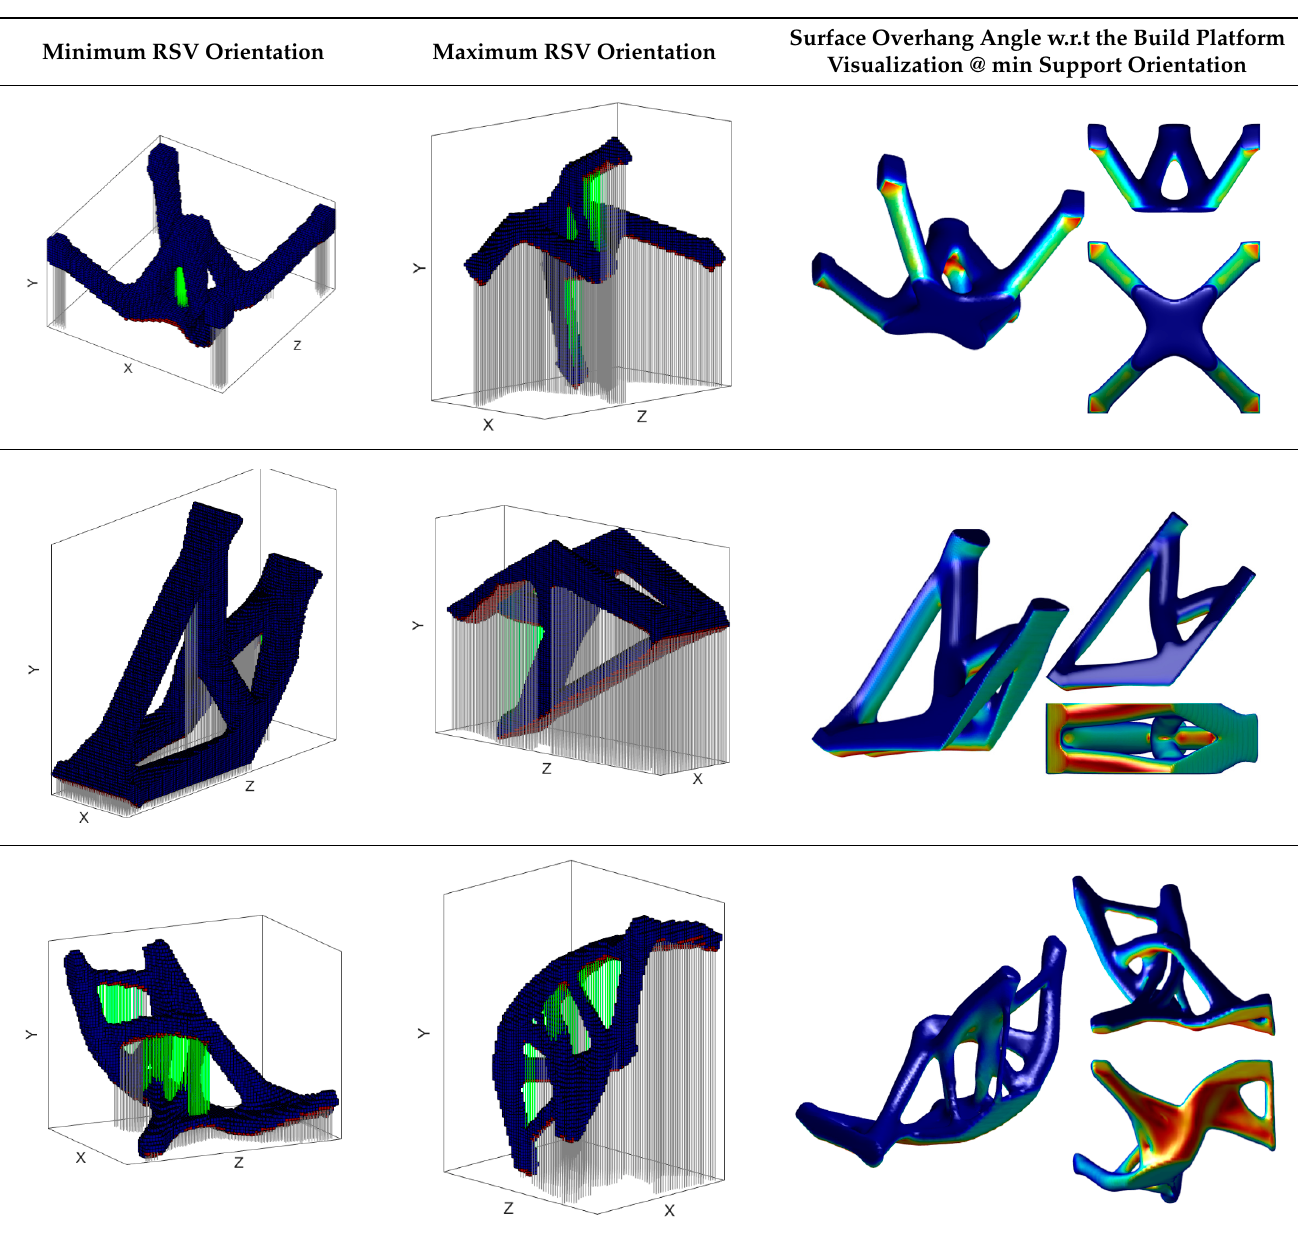
Table 2. Part orientations that minimize and maximize the required support volume with surface angle visuals of the minimum orientation.